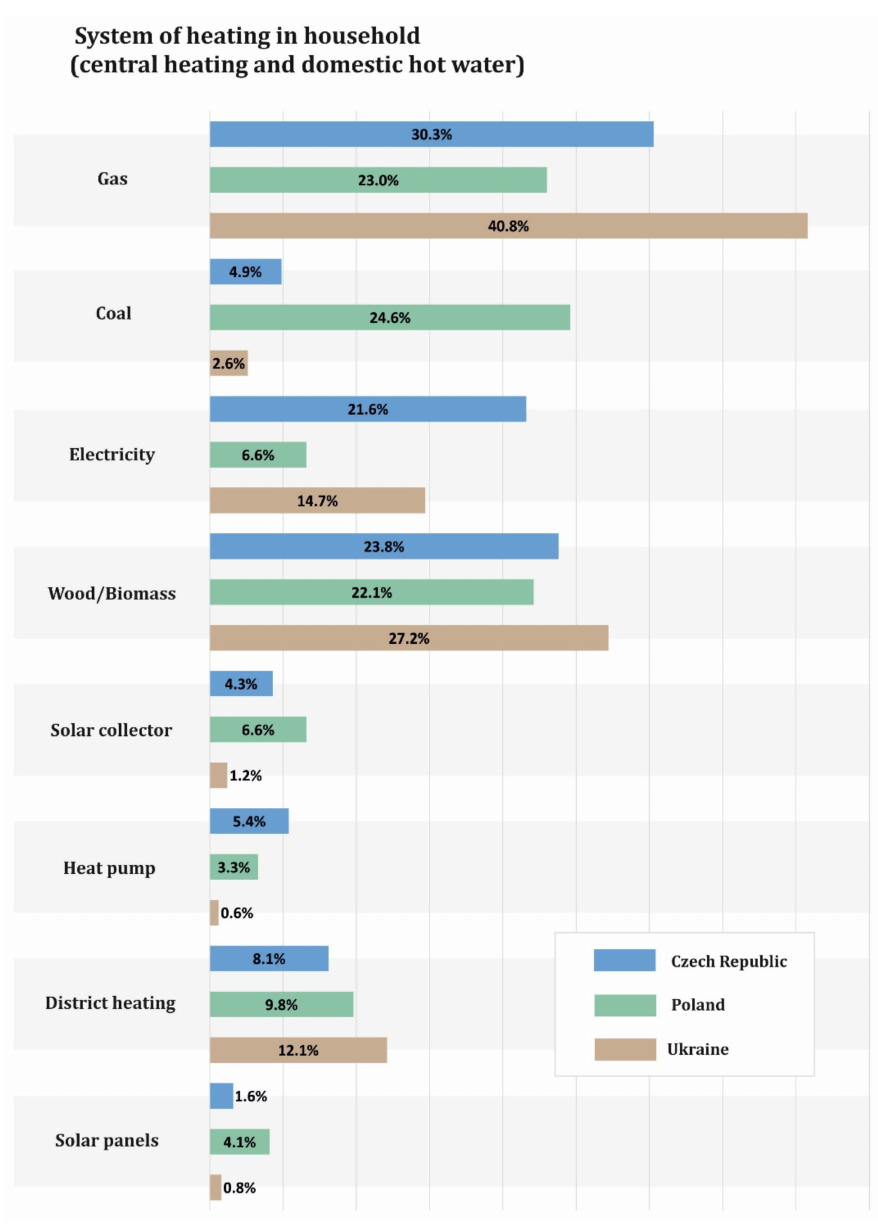
Figure 1. Heating system in the household. Source: own